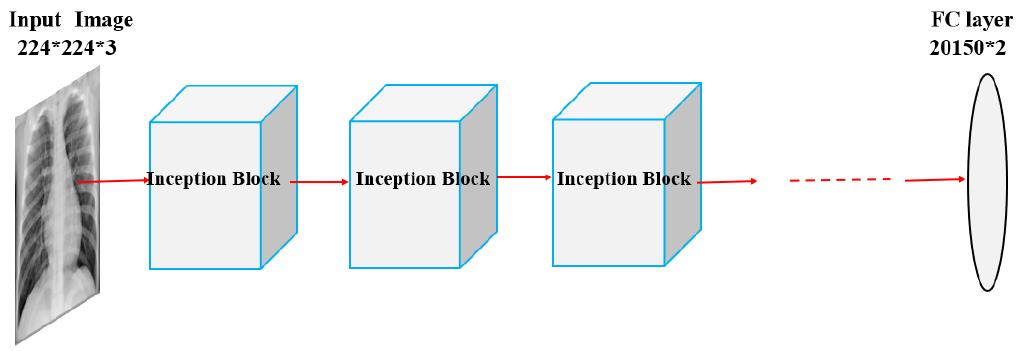
Figure A3. InceptionV3 architecture with Inception blocks comprising 1*1, 3*3, and 5*5 convolutions.